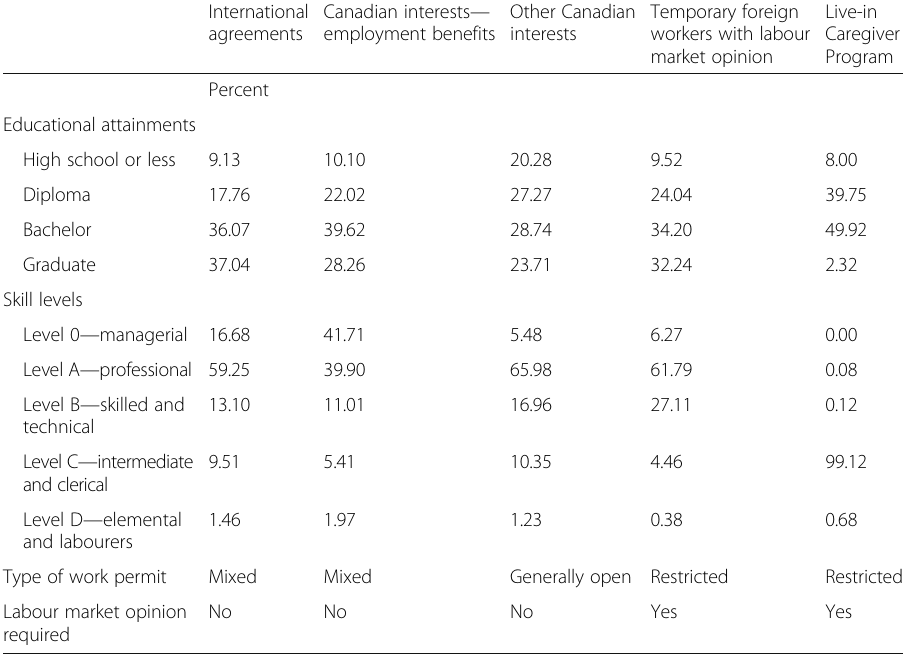
Table 1 Selected characteristics of temporary foreign workers, by streams, 1996 to 2012